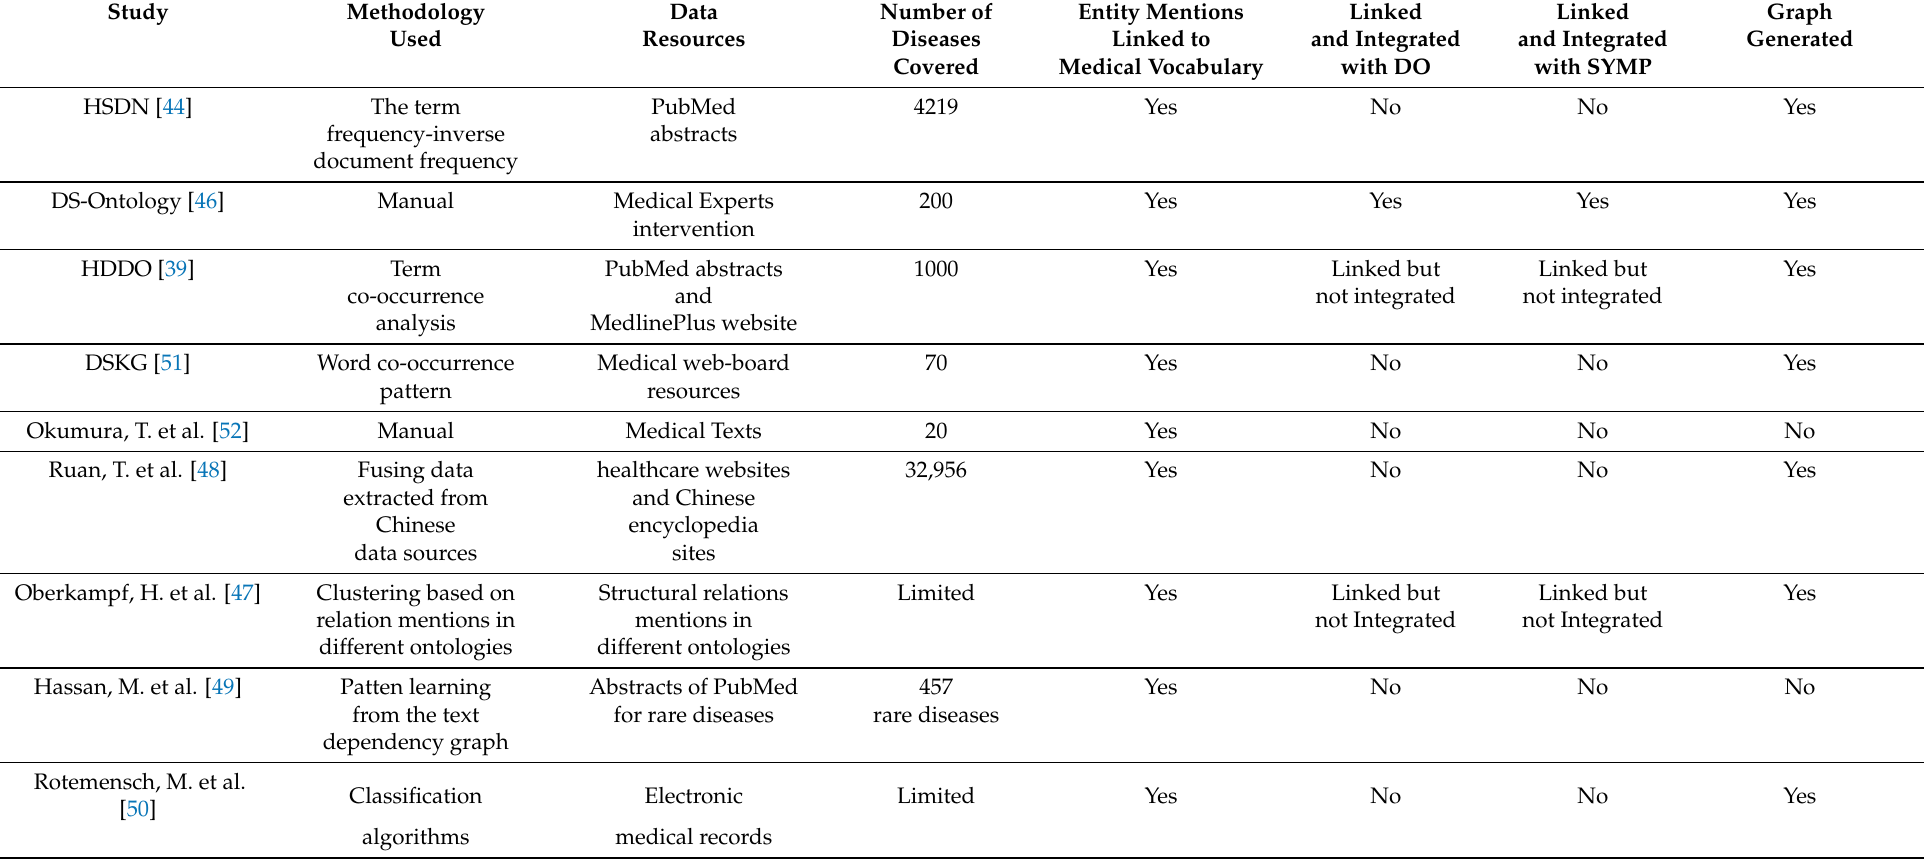
Table 1. Comparison between different